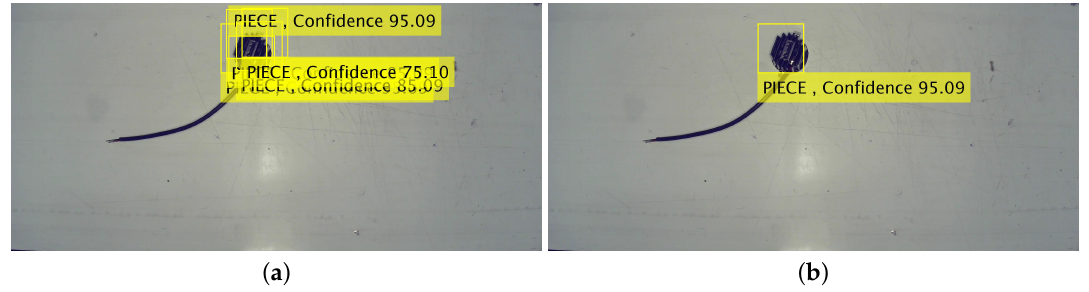
Figure 8. In panel ( a ) we show the multiple overlapping detection in step (i) and, in panel ( b ), the result after step